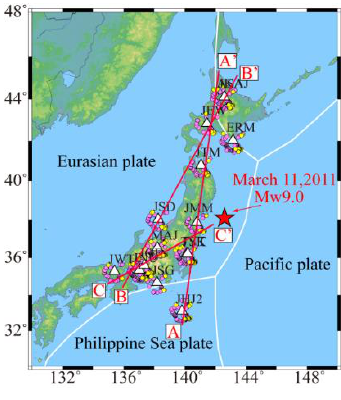
Figure 1: Distribution of seismic stations used in this study. The upper characters of the triangles denote the station codes. The purple and yellow circles denote the piercing points at 100km depth of PRFs and SRFs used in this study, respectively. The red star shows the epicenter of the 2011 Tohoku-Oki earthquake (Mw 9.0). The white curves denote the plate boundaries. The red lines show the three profiles in Figure 3‒5.